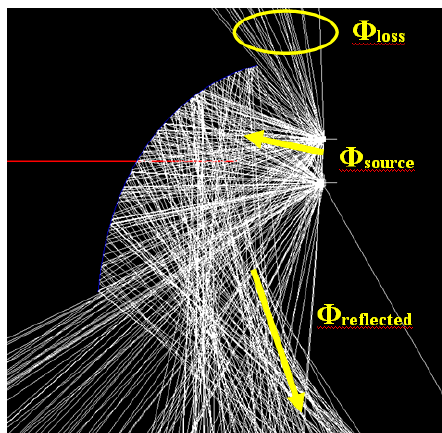
Figure 6. Image of forming the luminous intensity distribution by a reflector system and the LED source without focusing lenses.